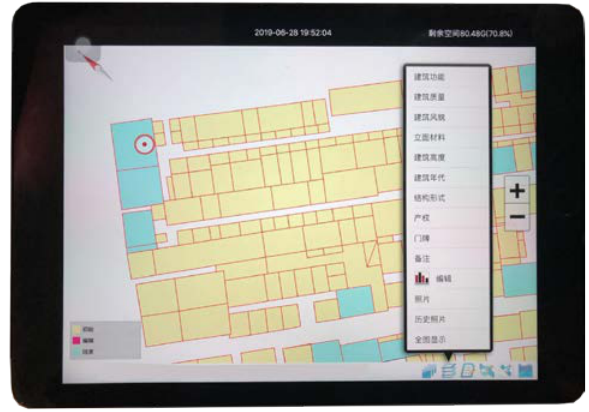
Figure 3 Mobile Terminal Research Tool interface Mobile terminal research tools mainly complete the following functions, such as map display, editing and operation, data acquisition, editing and query, GPS positioning, real-time display of thematic maps and so